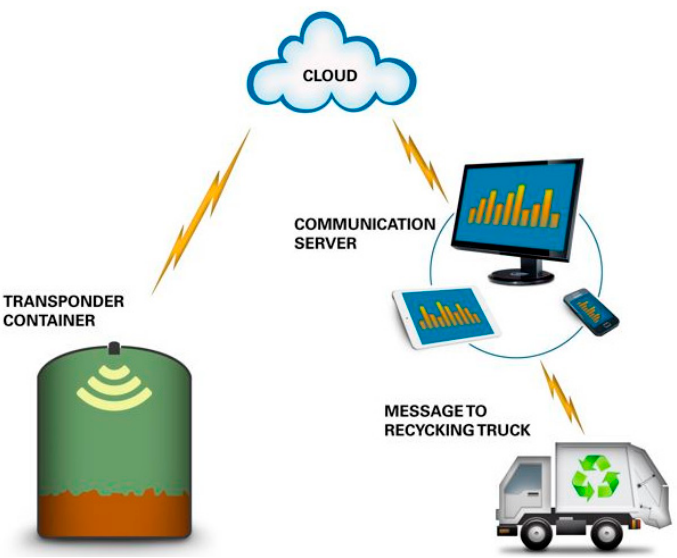
Figure 2. General outline of the Industrial Product-Service Systems (IPS 2 ) for optimizing recycling management.